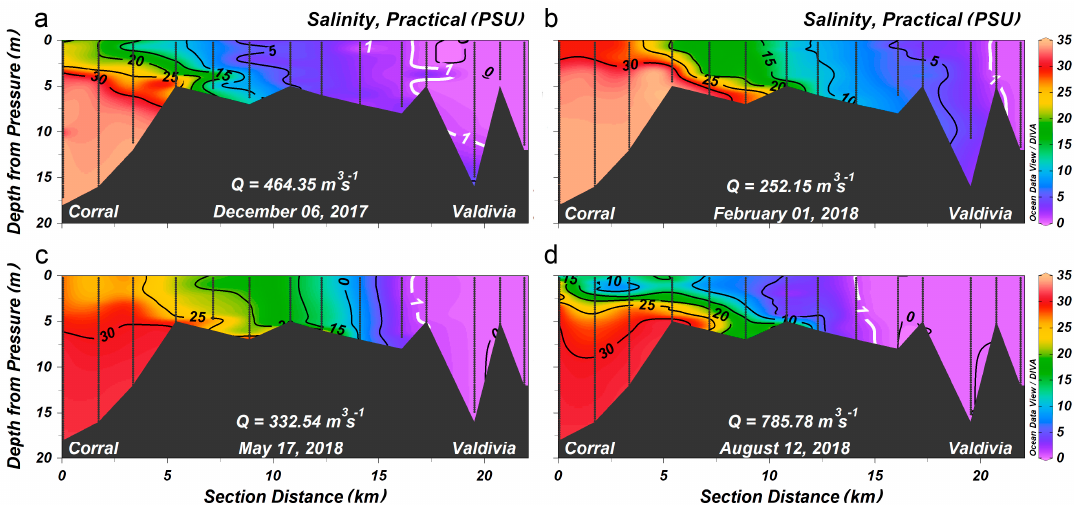
Figure 2. Mean salinity (ebb and flood tides) along the central axis of the VRE during spring tides for different seasons of the year. ( a ) Austral spring, 6 December 2017. ( b ) Austral summer, 1 February 2018. ( c ) Austral fall, 17 May 2018 and ( d ) Austral winter, 12 August 2018. The vertical gray lines in each panel mark the positions where the CTD profiles were taken. The black contour lines are isohalines in intervals of 5 PSU. The 1 PSU isohaline (white contour) was employed to determine the extent of saltwater intrusion; Q is the sum of the average flows of the Calle-Calle and Cruces rivers 7 days prior to sampling.